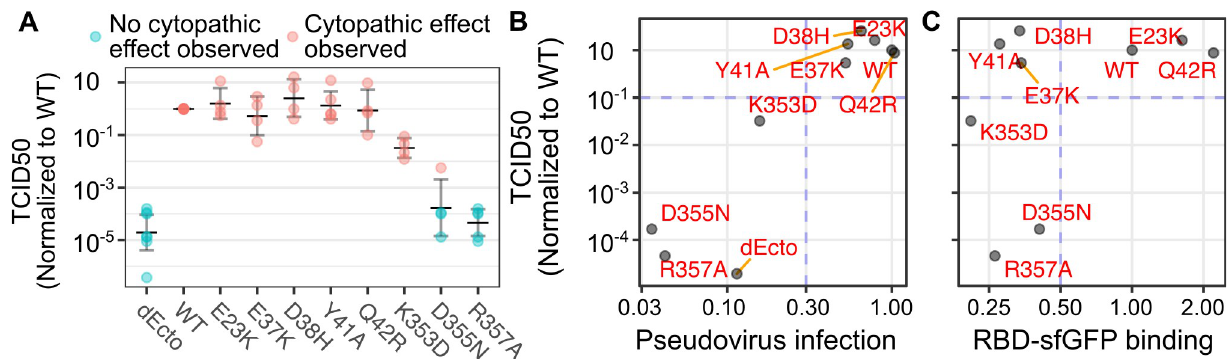
Fig 5. Comparison of ACE2 variant susceptibilities to SARS-CoV-2 replication with SARS-CoV-2 spike pseudovirus infection. A) Tissue culture infectious dose 50 assays, where dilutions of SARS-CoV-2 were added to 96-wells containing HEK 293T cells expressing the denoted WT or variant ACE2 proteins. TCID50 values were normalized to values corresponding to infection of WT ACE2 cells assessed in the same experiment. Samples colored in blue are those where no cytotoxicity was observed in any dilution, and these samples were given a nominal count of 1 to denote the limit of detection of the assay, and were then normalized accordingly. The horizontal dashes indicate geometric means across experiments. Error bars denote 95% confidence intervals. N = 3 or more replicates. B) Scatter plot comparing SARS-CoV-2 pseudovirus infection and geometric means of normalized TCID50 values shown in panel A. Blue lines indicate representative threshold values that separate permissive from non-permissive ACE2 variants. C) Scatter plot comparing published SARS-CoV-2 RBD-sfGFP binding values to geometric means of normalized TCID50 values.